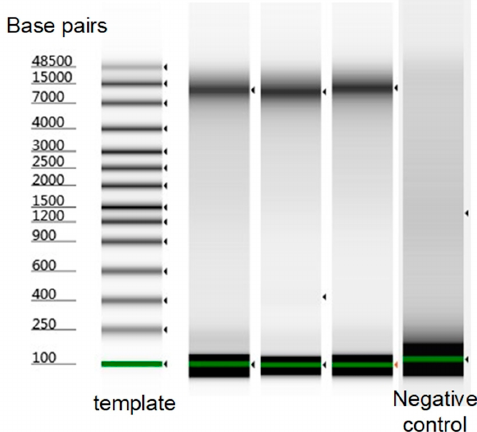
Figure 6. The tape station results of amplified DNA from single C. glutamicum cells using the optimized protocol. The DNA was not degraded. The results from three single C. glutamicum cells were shown, with one negative